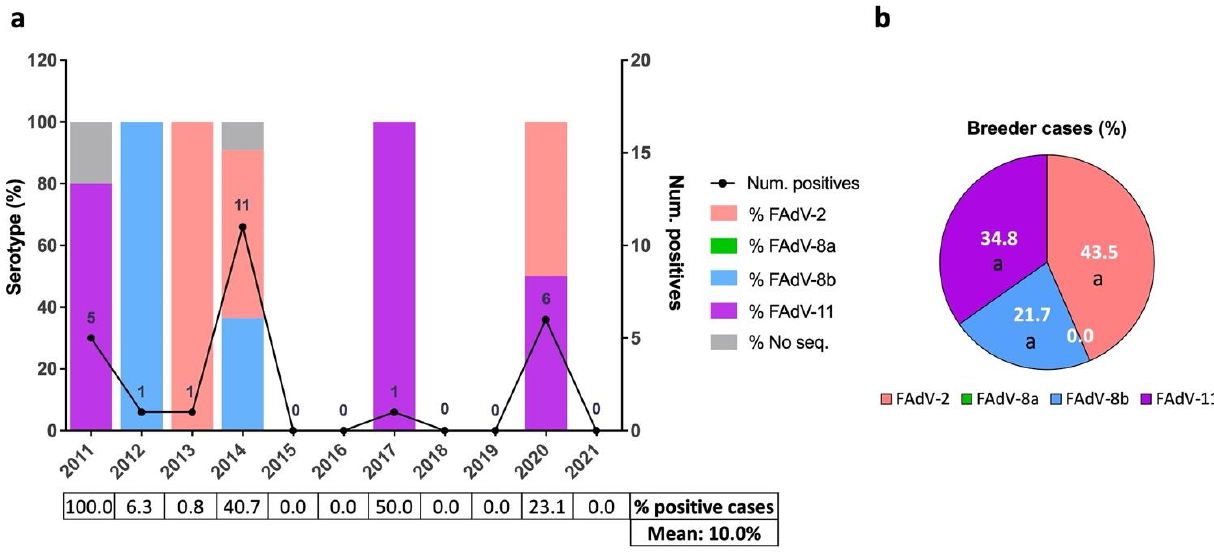
Figure 3. Distribution of IBH cases in broiler breeder pullets between 2011 and 2021 in Spain. ( a ) Number of positive IBH cases in broiler breeder pullets (black line, number of cases per year indicated, (right) y axis) and percentage of FAdV serotypes per year (color-coded bars, (left) y axis). The percentage of positive cases out of the suspected IBH cases submitted per year and overall is shown as a table below. ( b ) Overall percentage of FAdV serotypes in positive IBH cases in broilers. Different letters designate statistical significance in Fisher’s exact test ( p ≤